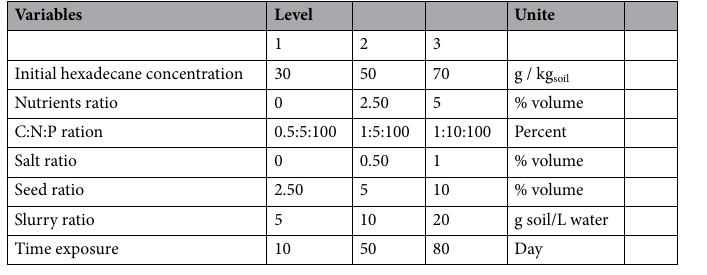
Table 1. The design